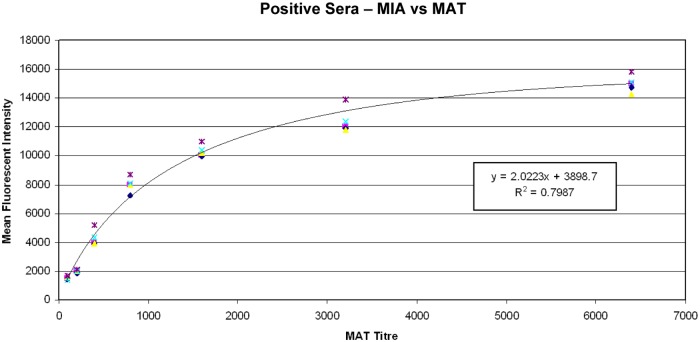
Standard curve for cut-off points.